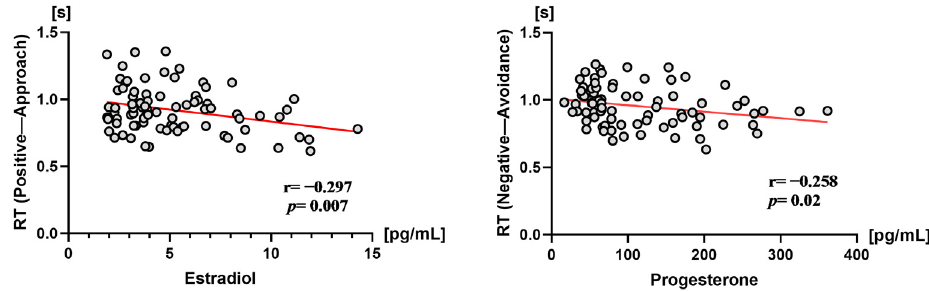
Figure 5. Correlation scatter plots between sex hormone levels ( left : estradiol; right : progesterone) and reaction time in Experiment 1.